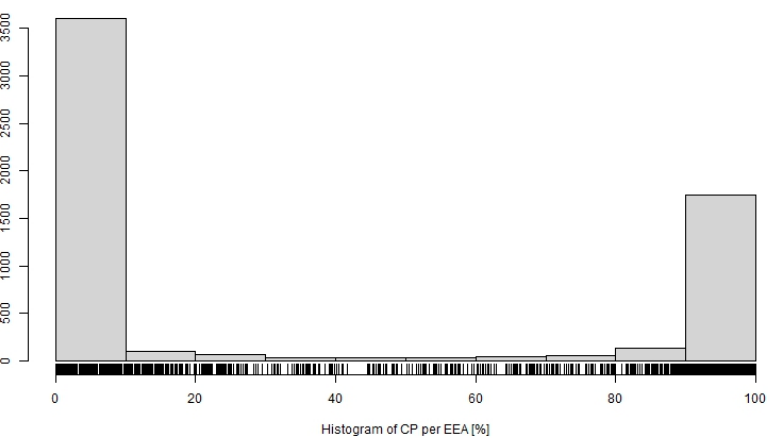
Figure 6. Distribution of EEAs by percentage of contributing areas of critical points (CP) endan- gering municipalities. Characteristics of horizontal axis are as follows: Min.: 0.00%; Q1: 0.00%; Median: 0.00%; Mean: 34.44%; Q3: 98.10%; Max.: 100.00%; SD: 45.38%.